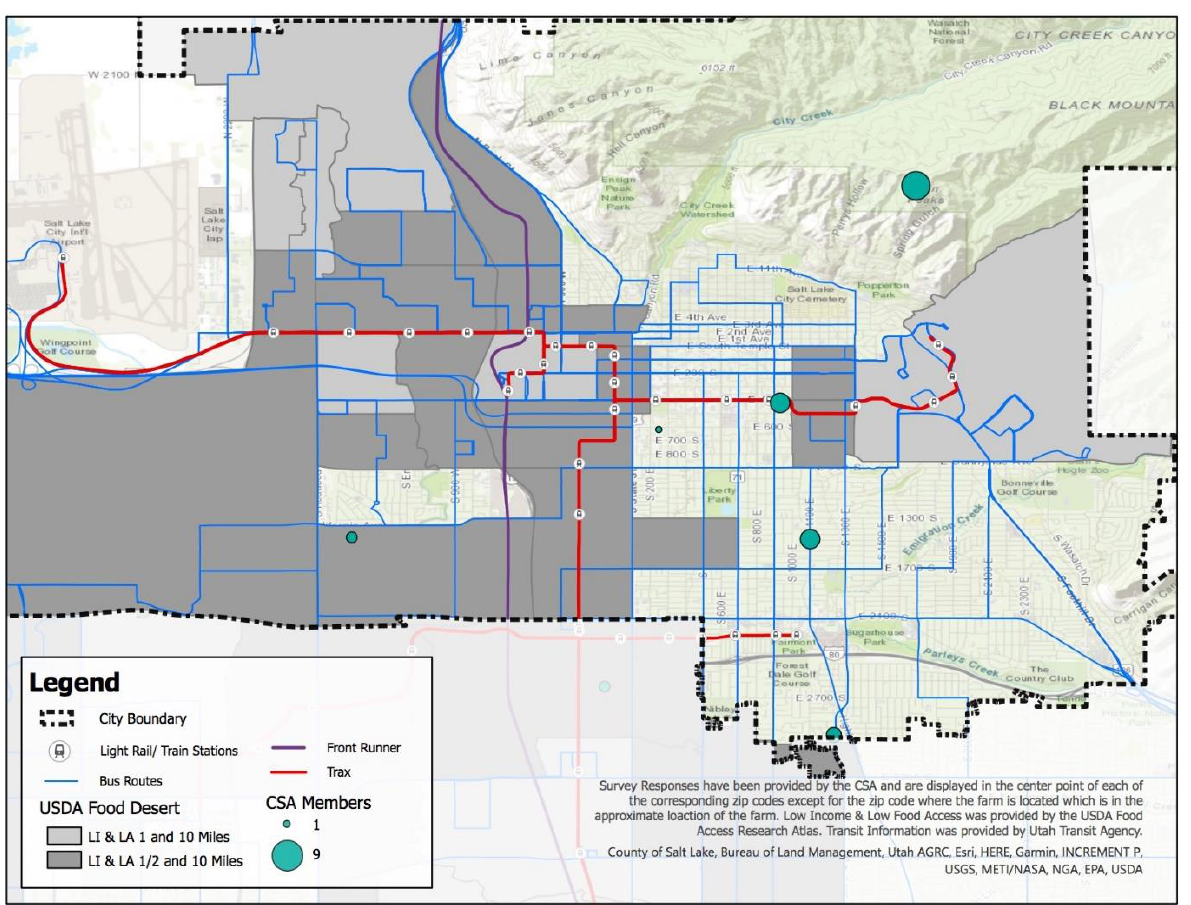
Figure 1. USDA Food Deserts and B.U.G. Farms Community Supported Agriculture Food